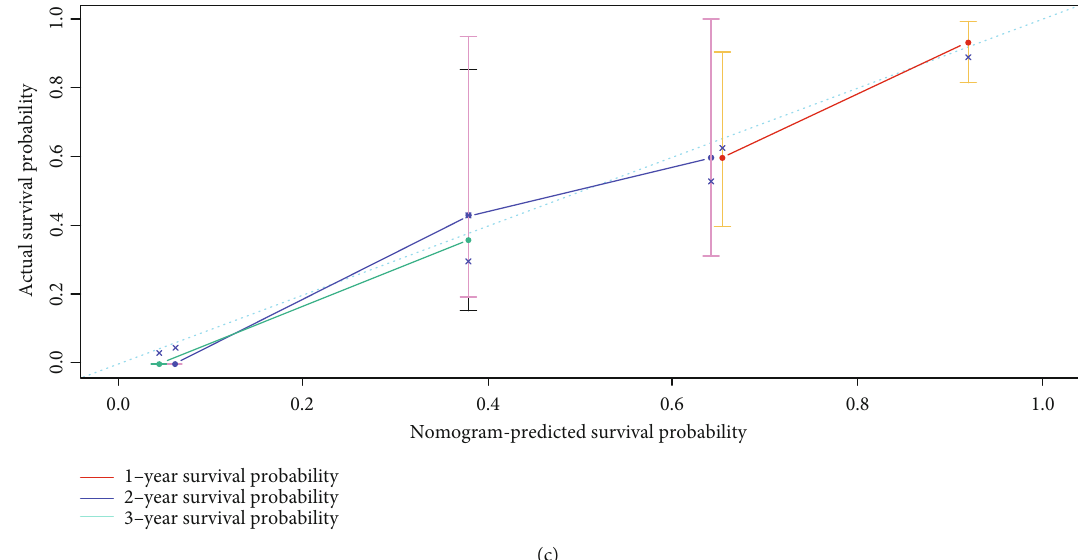
Figure 6: The nomogram constructed by radiomics signature, KPS, and age (a). The calibration curve of the nomogram shows that the prediction and observation possibilities of TCIA (b) and test (c) datasets are